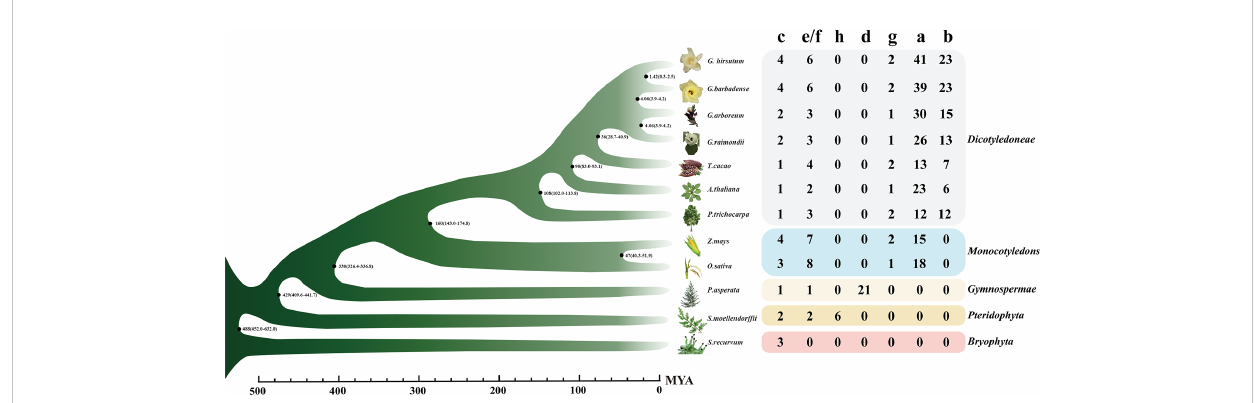
FIGURE 2 The numbers of the TPS gene family of 12 species. The bar value below indicated the time of species divergence. On the right side were species name, species, number of genes in different TPS subfamilies and species classi fi cation. Different colored squares indicated different species classi fi cations. The phylogenetic drawing was based on timetree. MYA, A million years